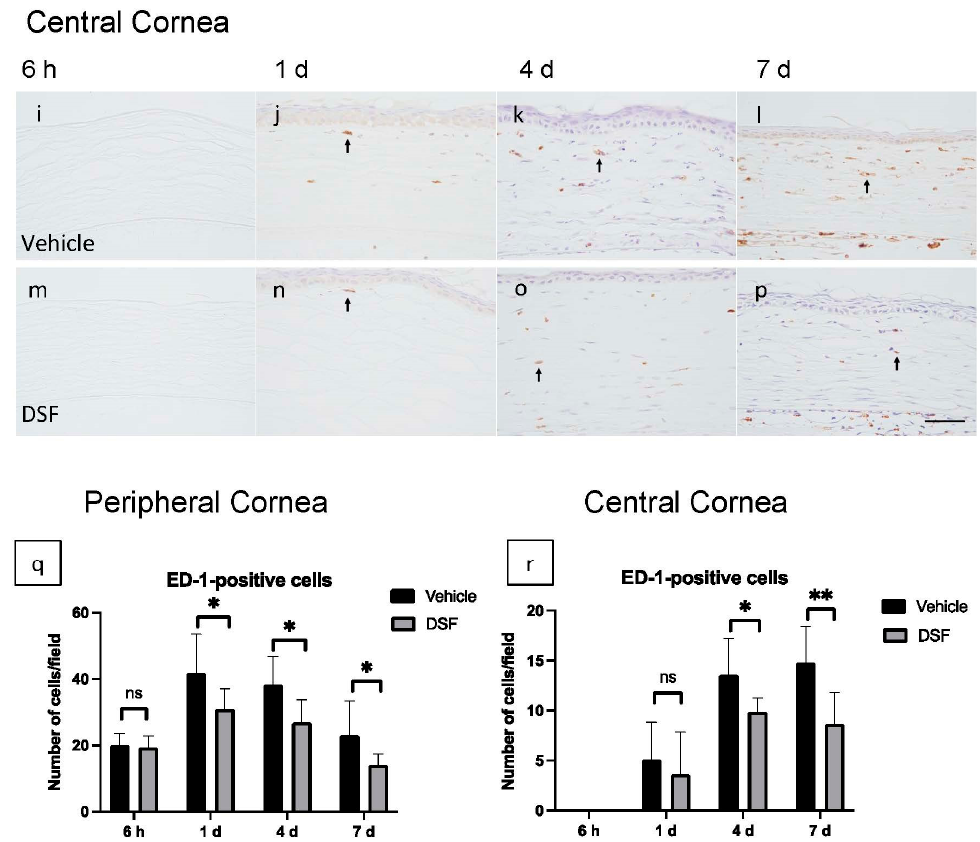
Figure 2. ED-1 staining was performed to evaluate macrophage infiltration in the rat cornea after alkali burn. Immunohistochemical images of the peripheral cornea at 6 h and 1, 4, and 7 days are shown (Vehicle group: ( a – d ), DSF group: ( e – h ) ). Immunohistochemical images of the central cornea at 6 h and 1, 4, and 7 days are shown (Vehicle group: ( i – l ) , DSF group: ( m – p ) ). The number of ED-1-positive cells infiltrating at four endpoints in the Vehicle and DSF groups were compared. Peripheral corneas showed a statistically significant difference after 1 day ( q ). Central corneas showed a statistically significant difference after 4 days ( r ). Bar, 50 μ m. The black arrows indicate ED-1-positive cells. Data are presented as mean ± standard error ( n = 8 samples/group). ”ns” means no significant difference. ** p < 0.01, * p < 0.05.